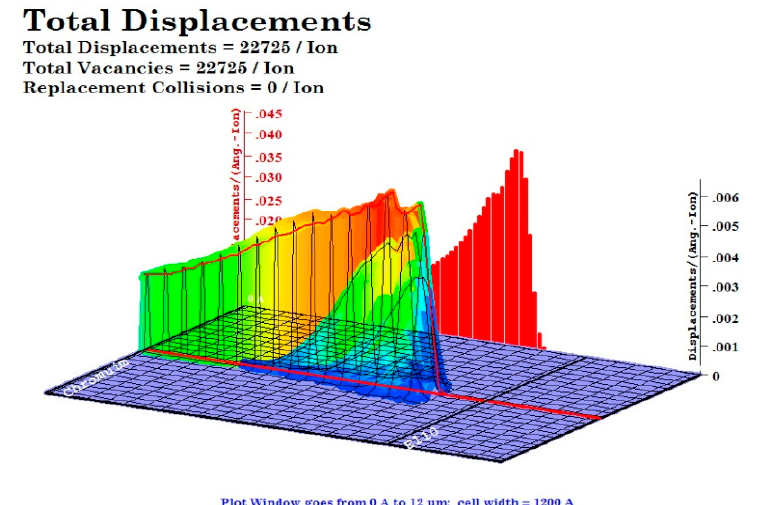
Figure 5. Damage caused by 120 MeV Tc in E110 alloy, coated with 9 µm thin film of Chromium (Cr).